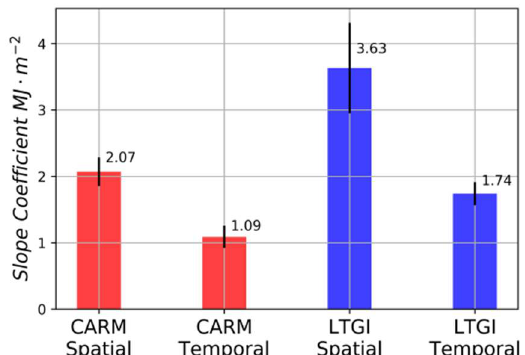
Figure 6. Distributions of slope coefficients related to the spatial and temporal models for the LTGI (blue) and CARM (red) experiments (mean ± SE).